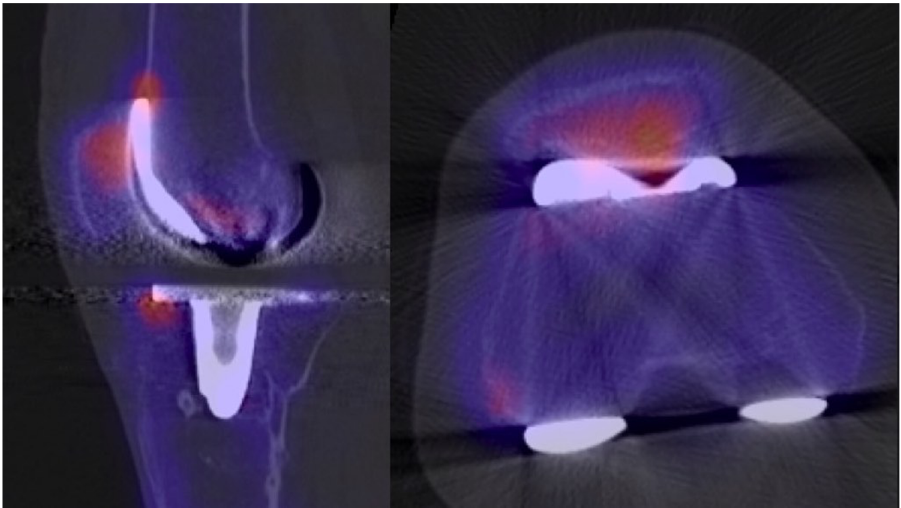
Figure 3. Increased bone tracer uptake on the patella in sagittal and axial plane indicating increased patella loading due to posterior instability.